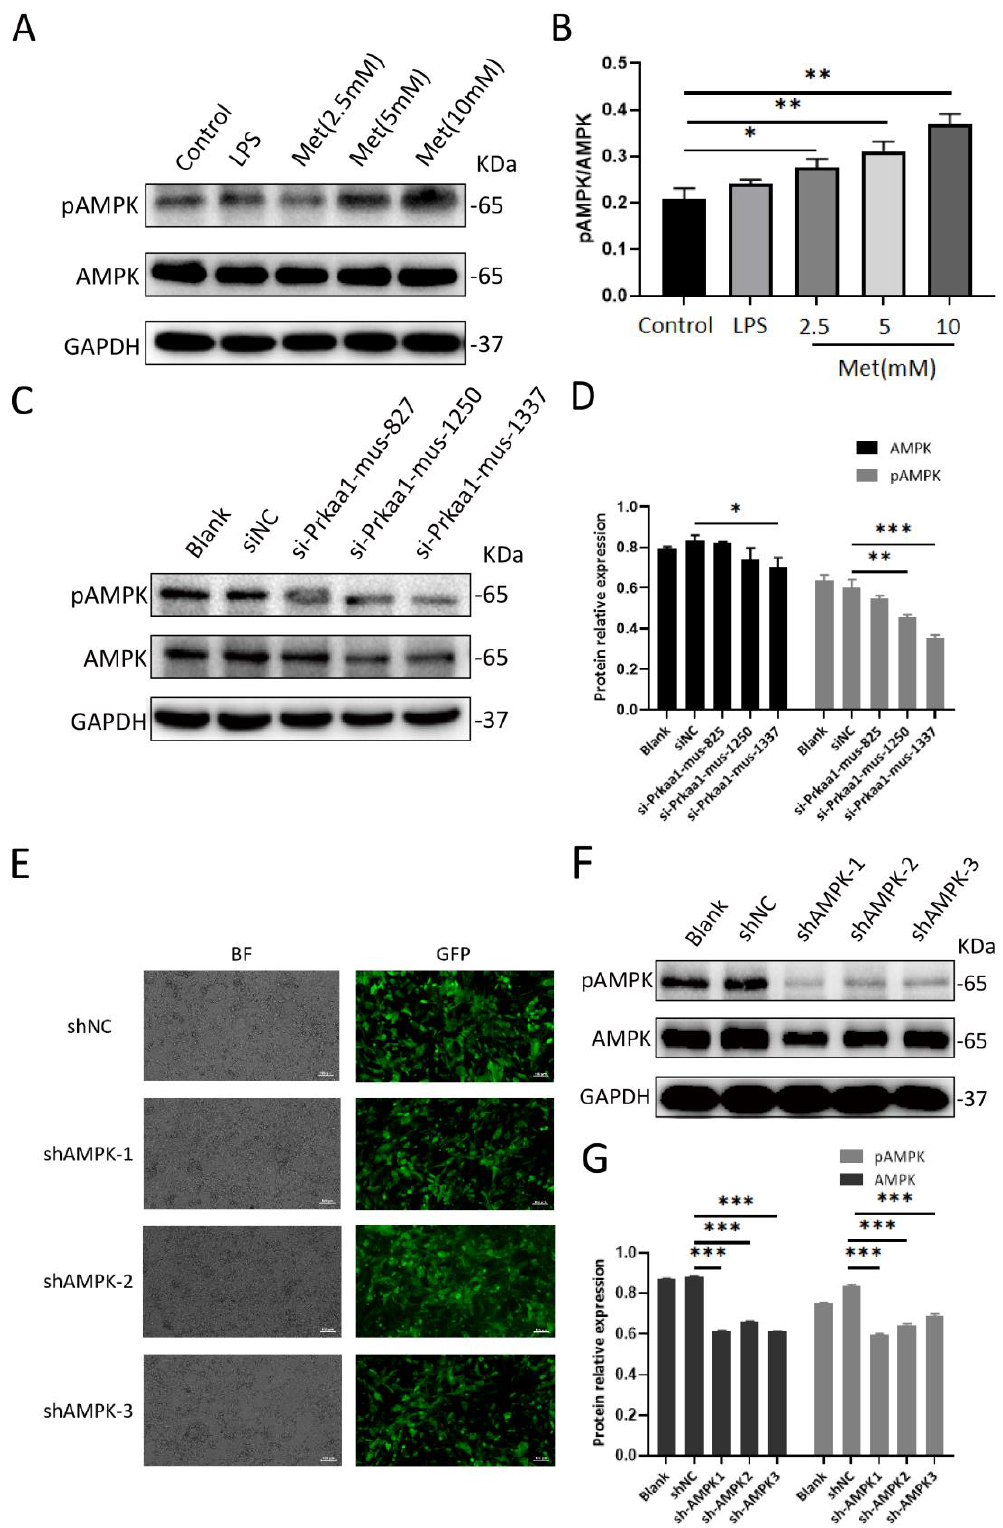
Figure 1. Metformin activates AMPK in a dose−dependent manner in NIH 3T3 cells. The efficiency of siRNA and shAMPK knockdown of AMPK in NIH 3T3 cells was verified by Western blotting for further experiments. ( A , B ) Protein expression of pAMPK and AMPK in NIH 3T3 cells with various doses of metformin treatment was detected by Western blotting. GAPDH was used as an